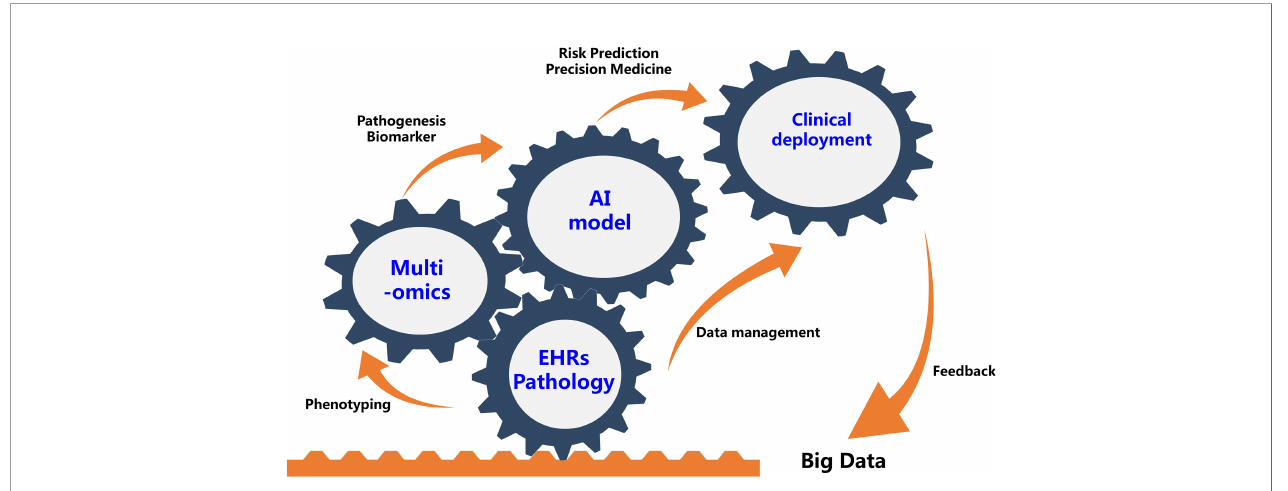
FIGURE 1 | Future Integration of Arti fi cial Intelligence And Multi-omics Will Bene fi t Precision Medicine for Immune-Mediated Disorders. EHRs, electronic health